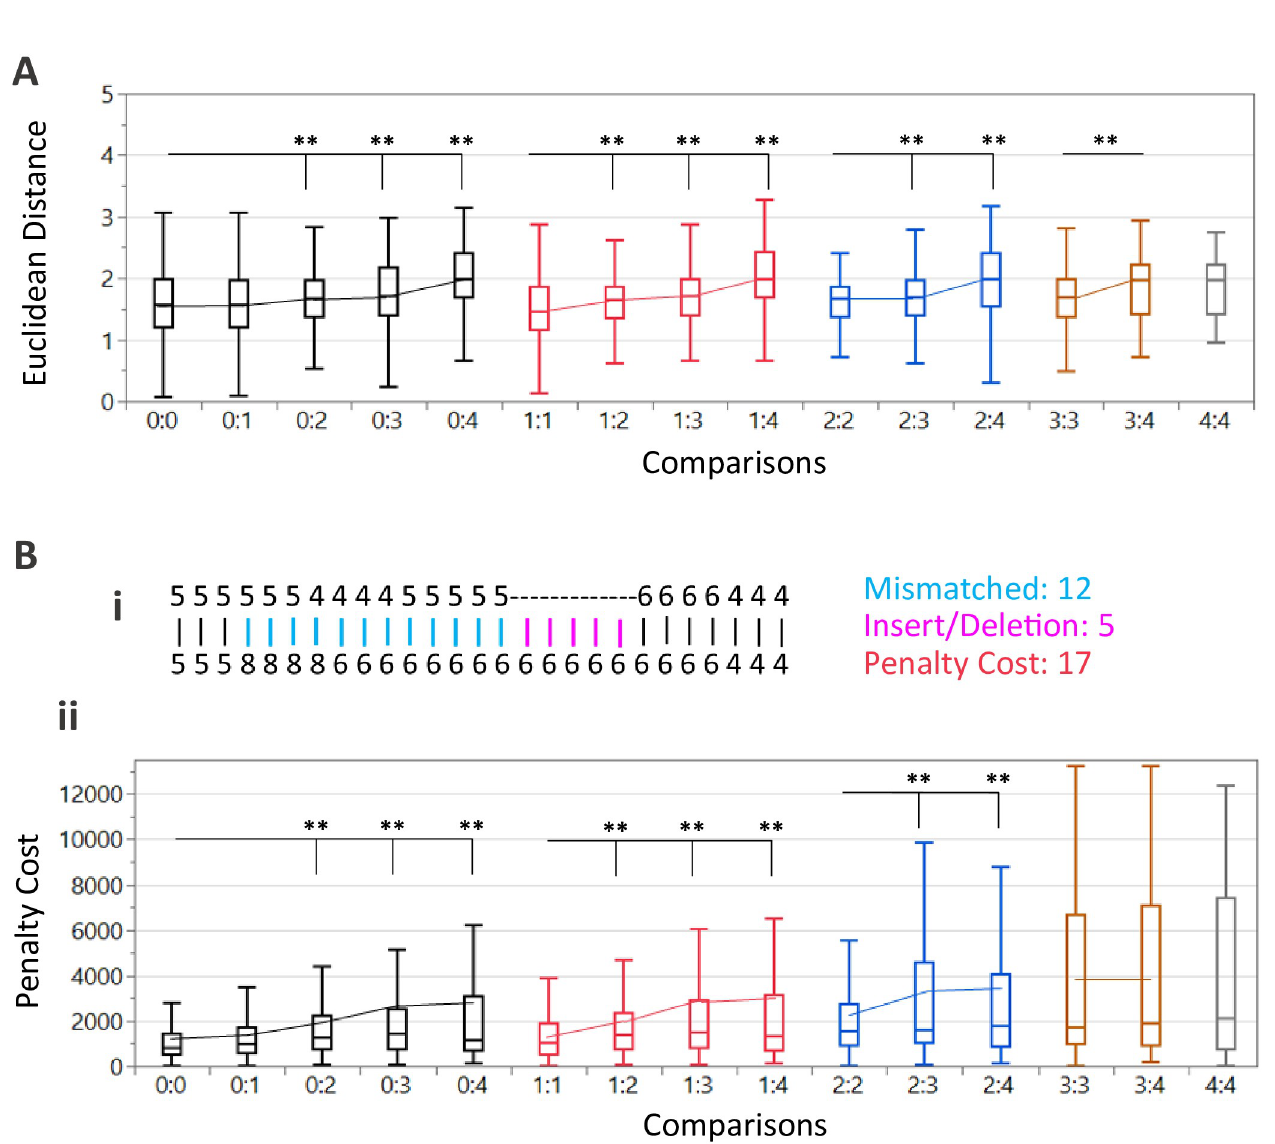
Fig 6. (A) Euclidean distances between transition probability matrices for each feed state. Box plot colors (black, red, blue, orange, grey) are used to help focus trends in specific comparisons groupings, while the line is connecting each box plot mean . For example, the black boxes are showing that each feed state exhibits an increasing Euclidean distance away from 0-fed, indicating a greater difference in transition probability profiles. The upward trend seen for the black grouping means that as satiety increases, behavior transitions progressively increased in dissimilarity when compared to the 0-fed state. All the colored groupings show similar trends, with ANOVA analysis showing a pValue < 0.05 for all groups. Tukey pairwise comparisons are shown: � p < 0.05 and �� p < 0.01. (B) Penalty cost as a metric of sequence structure similarity. (Bi) Demonstration of PC calculation showing the cost incurred to edit a mismatch and insert/deletion. (Bii) Penalty cost from each feed state was compared to all other feed states. As was the case with (B), the connecting line in (Bii) is connecting each box plot mean . Black, red, and blue groupings show upward trends in the PC, indicating that sequence structure progressively changes as satiety increases (ANOVA analysis showing a pValue < 0.05 for these groups). Tukey pairwise comparisons are shown: � p < 0.05 and �� p < 0.01. No statistical difference was seen in structure when comparing the 0- to 1-fed sequences, nor when comparing the 3- to 4-fed